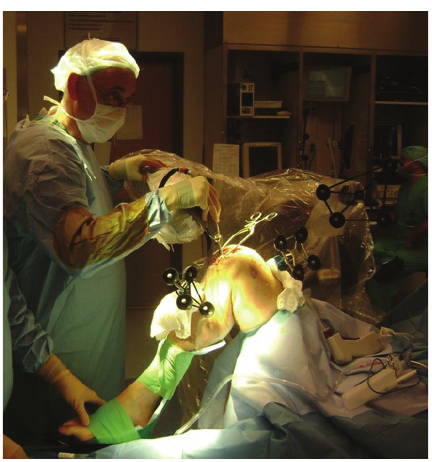
Figure 3: Placement of the femoral and tibial marker